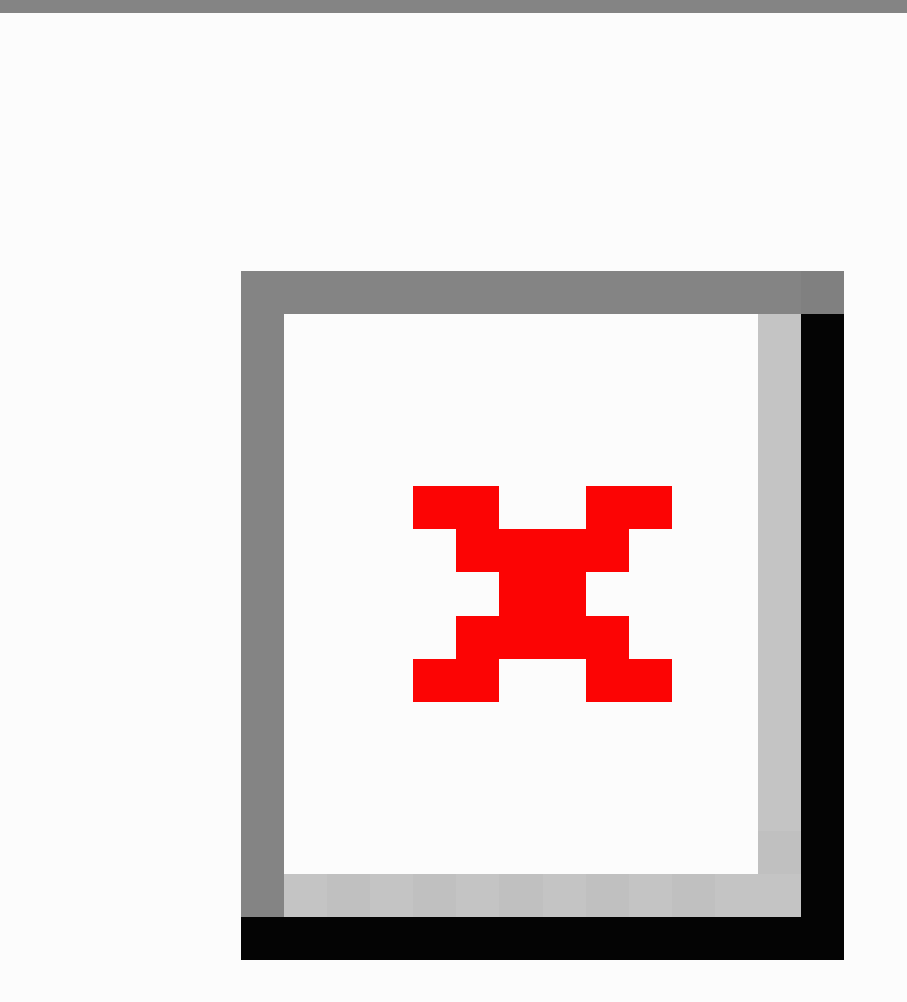
Figure 2. Number of HT systematic reviews and meta-analyses published per